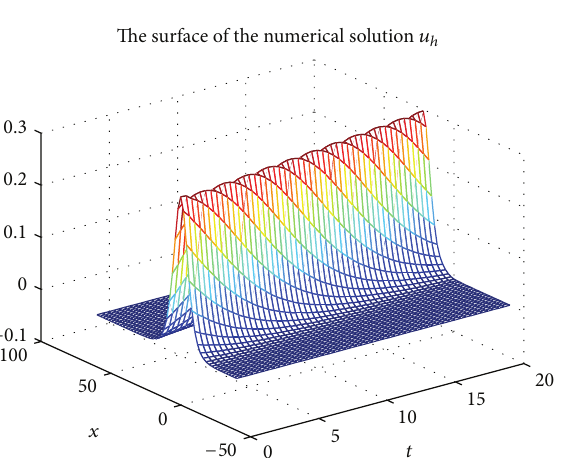
Figure 4: Surface for numerical solution 𝑞 ℎ